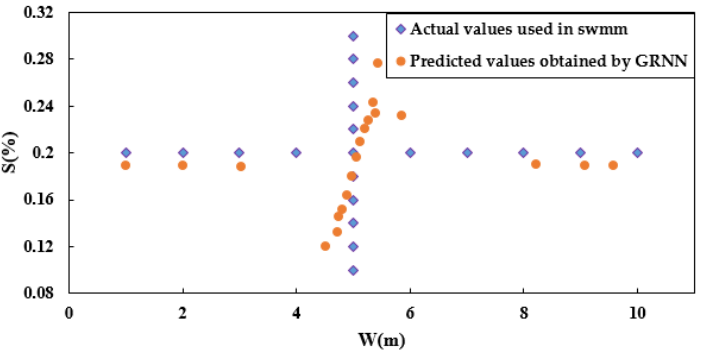
Figure 6. Relationship between actual values used in storm water management model (SWMM) and predicted values obtained by GRNN.